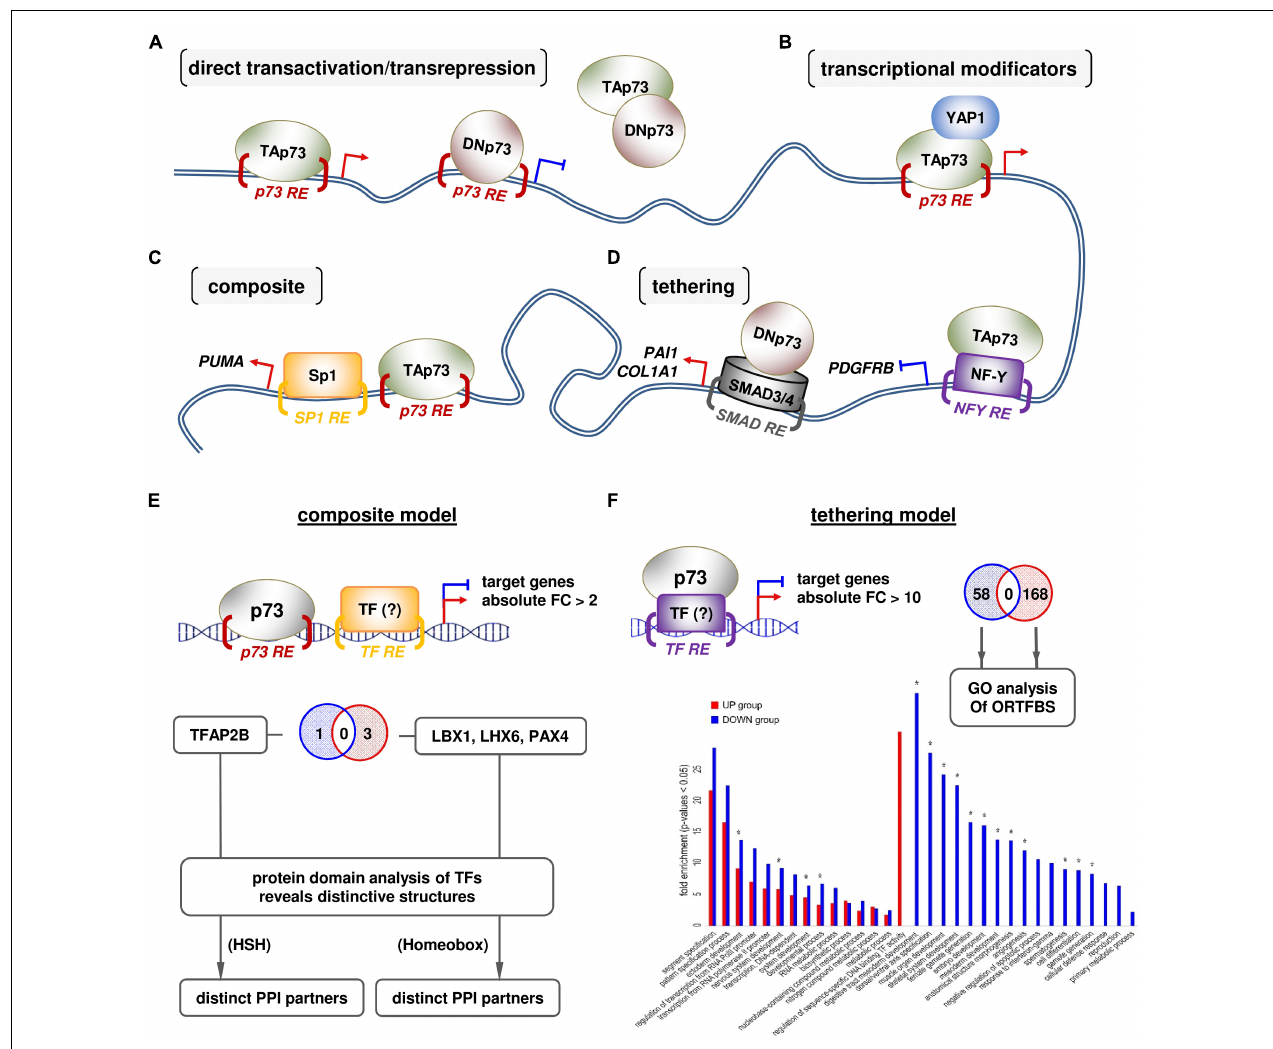
FIGURE 3 | An interplay of gene promoter architecture with p73 binding partners orchestrates the functional diversity of the p73 isoforms. (A) Typical transcription factor-based and (B–D) PPI-based modes of genomic action of p73 isoforms. (E,F) Computational prediction of p73 PPIs relative to the promoter architecture by meta-analysis of extrapolated p73 ChIP-seq and Mel.DNp73 microarray data (Koeppel et al., 2011; Steder et al., 2013). (E) Composite scenario: the overrepresentation ( Z -score) of transcription factor binding sites (ORTFBS) in the DNp73-responsive gene groups (using Pscan software): (A1) > 2 × over-expressed (OE); (A2) > 10 × OE; (B1) > 2 × underexpressed (UE); (B2) > 10 × UE. The groups A1 and B1 were integrated with ChIP-seq data on p73 binding sites. The distance of the p73REs from the selected TFBS in A1 and B1 groups was calculated by Pscan using the “Report Occurrences” function with a PWM-threshold of 0.75. The distance score was set as 1 if the distance was within a range of 15–250 bp and to 0 otherwise. Afterward, the relative number of close TFBS within each group was calculated by setting up the ratio of positive distance hits to the total number of genes in the respective group. This ratio in each group (A1, B1) was compared to the ratio of the same TFBS versus all genes in the microarray to calculate the enrichment of close TFBS. The enriched TFBS were significantly close to the respective p73RE in group B1 (estimated by t -test), whereas a significant enrichment in group A1 could only be found for one TF. (F) Tethering scenario: factors that bind DNp73 were predicted using the A2 and B2 groups of DNp73-responsive genes. The number of TFs recognizing the enriched ORTFBS for A2 and B2 were 58 and 158, respectively. The functions in which TFs are involved were predicted by GO-term